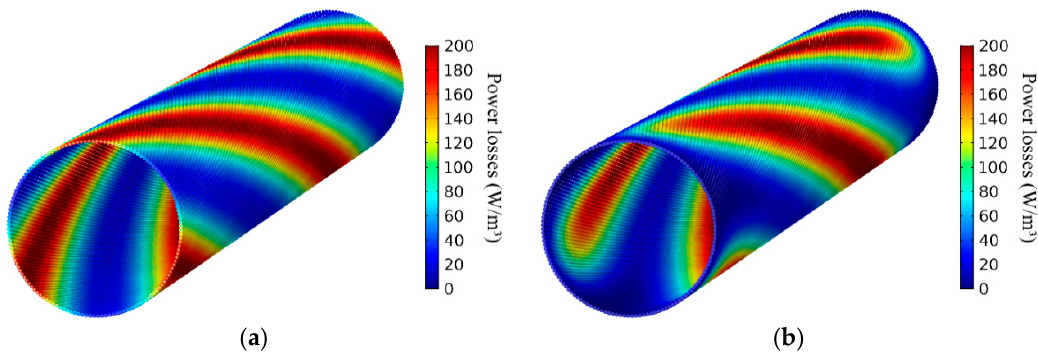
Figure 2. Distribution of armor losses in: ( a ) periodic FEM model; ( b ) non ‐ periodic 3D FEM model.